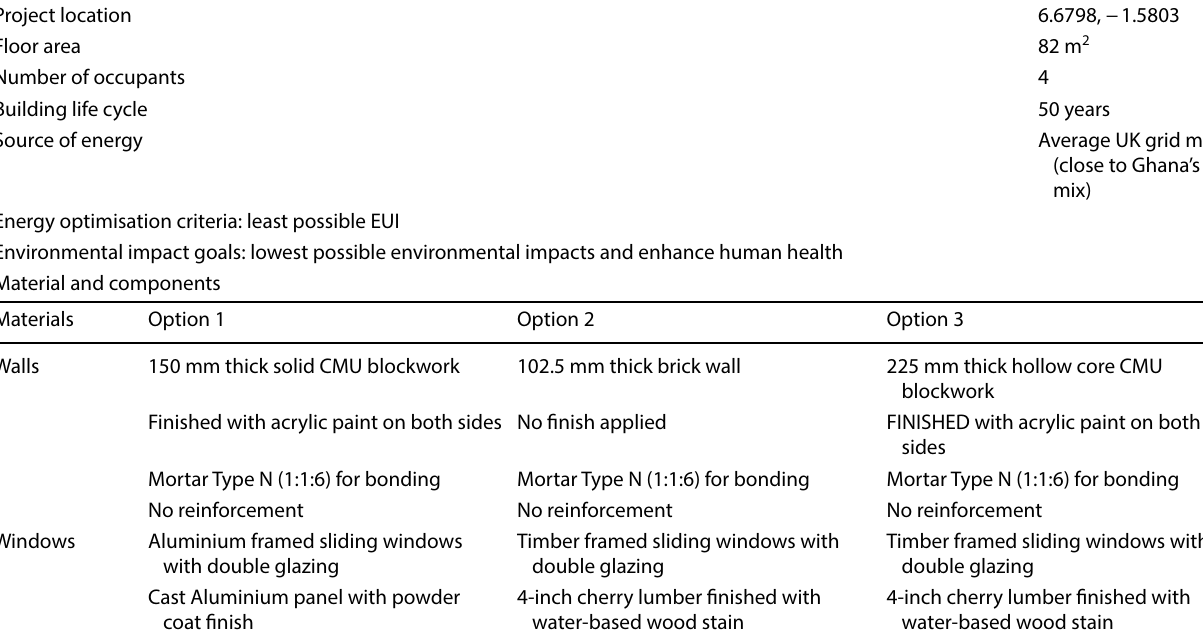
Table 7 Schedule of project data and SBD goals for simulations Project data sheet Project